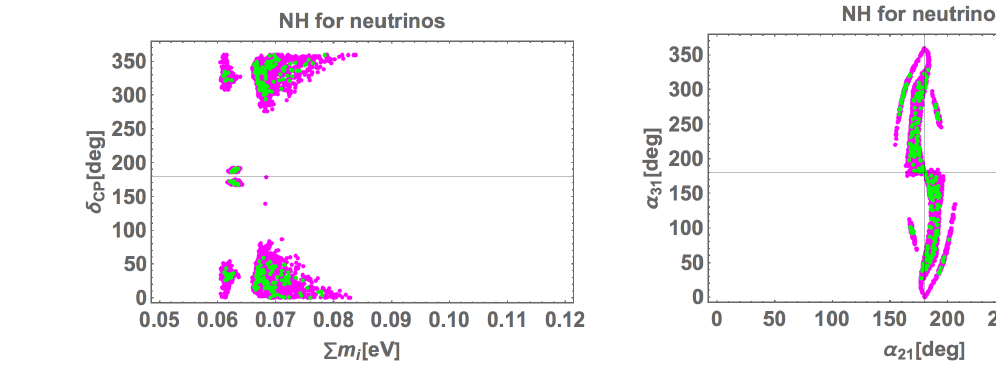
Figure 4 . Predicted Majorana phases α 21 and α 31 for NH. Colors denote same ones in figure